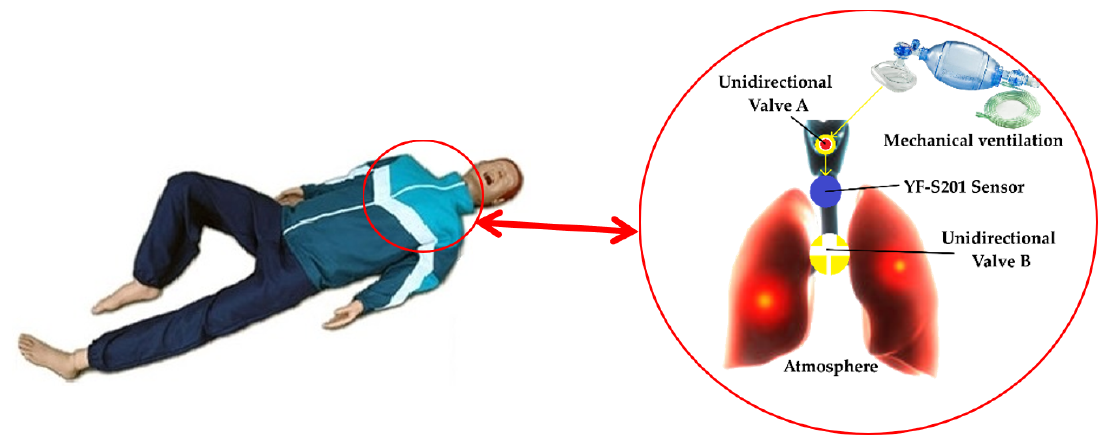
Figure 4. Air route inside the manikin. Adapted from CanStock and SimulaCare.